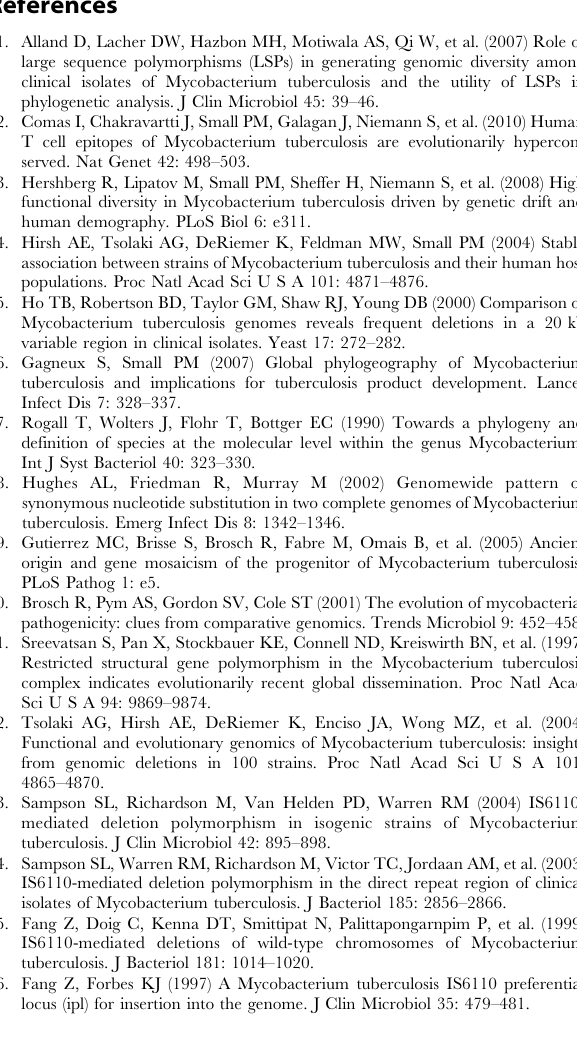
Figure S4 Coverage plot showing RD181: 2,535,429 to 2,536,140 spanning genes Rv2262c to Rv2263. (TIF) Figure S5 Coverage plot showing RD150: 1,896,862 to 1,899,349 spanning genes Rv1671 to Rv1674c. (TIF) Figure S6 Coverage plot showing RD142: 1,332,182 to 1,335,033 spanning genes Rv1189 to Rv1192.